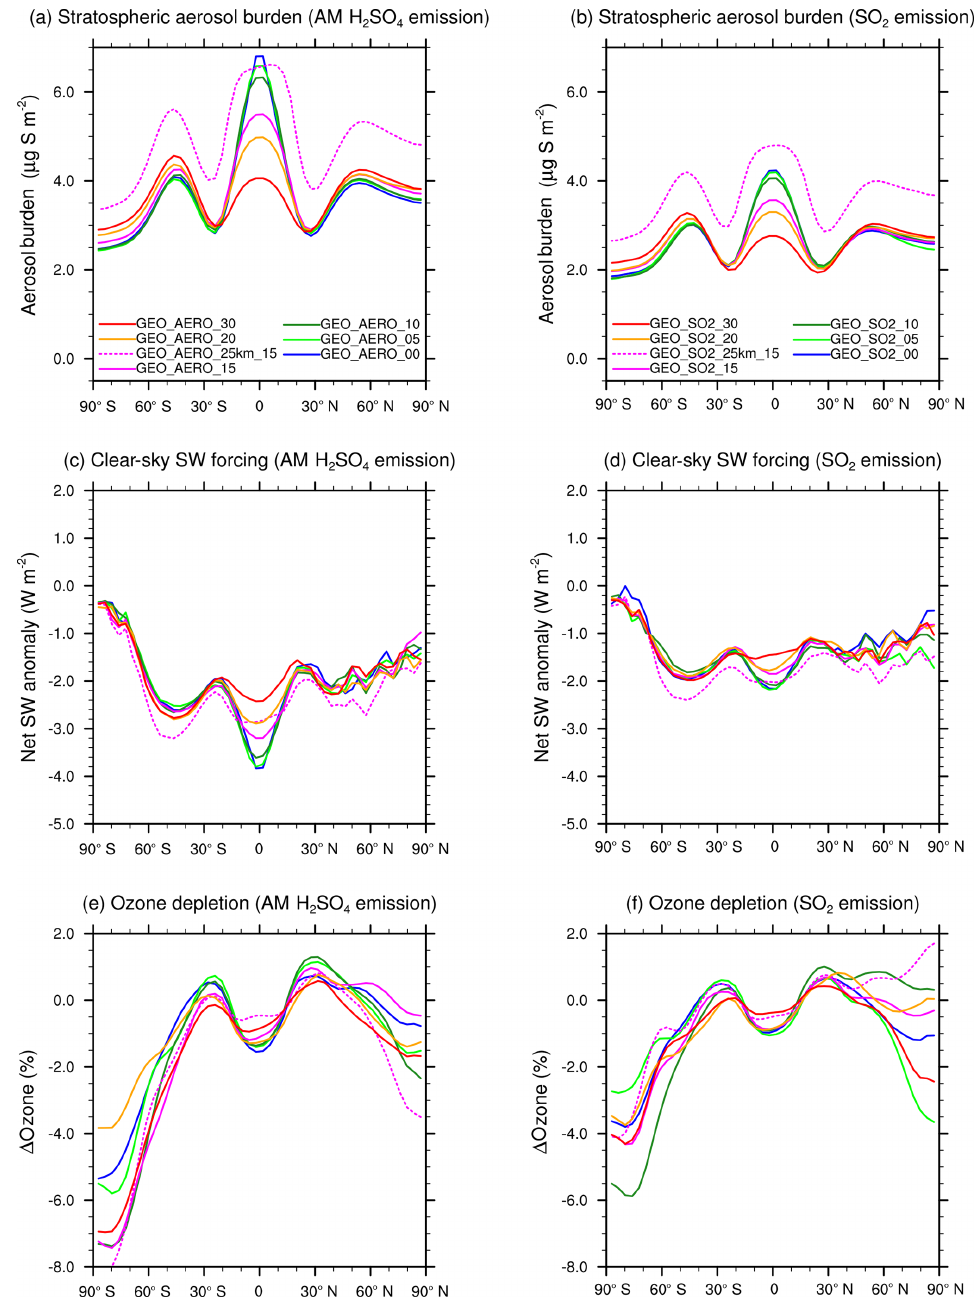
Figure 7. Zonally averaged stratospheric aerosol burden (a) and (b) , clear-sky SW radiative forcing (c) and (d) , and depletion of the total ozone column (e) and (f) as a function of latitude for AM H 2 SO 4 (a) , (c) , and (e) and SO 2 (b) , (d) , and (f) emission scenarios with different latitudinal spread as well as for emissions at 25km for